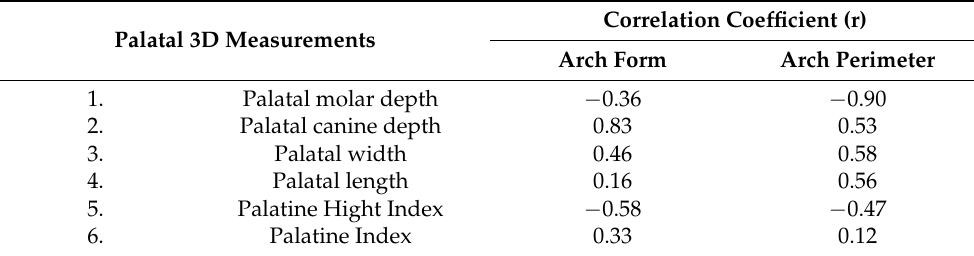
Table 4. Correlation of three dimensions of the palate with arch form and arch perimeter.